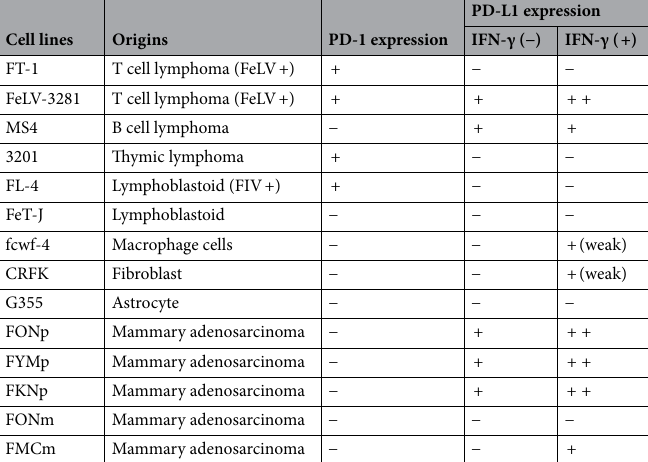
Table 1. Summary of PD-1 and PD-L1 expressions in feline cell